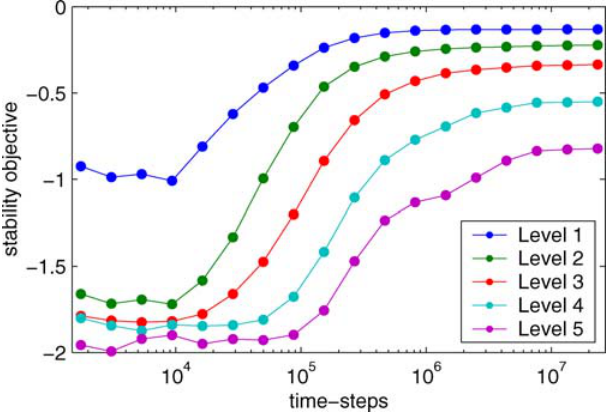
Figure 2. The Stability Objective as a Function of Time for the Five Different Cortical Levels After an initial phase, within which the transients due to initial conditions have decayed, learning is initiated after 10,000 time steps. DOI: